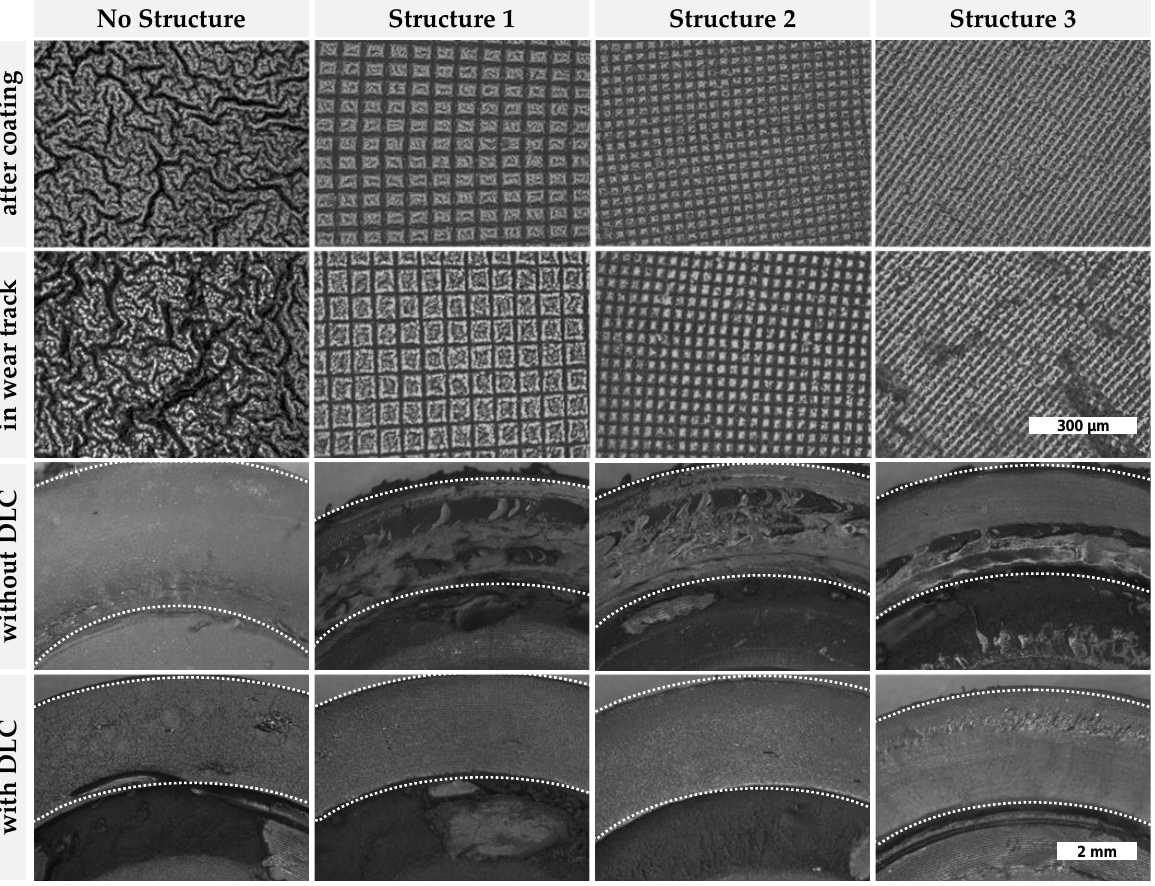
Figure 8. DLC coated surfaces before and after tribological loading.